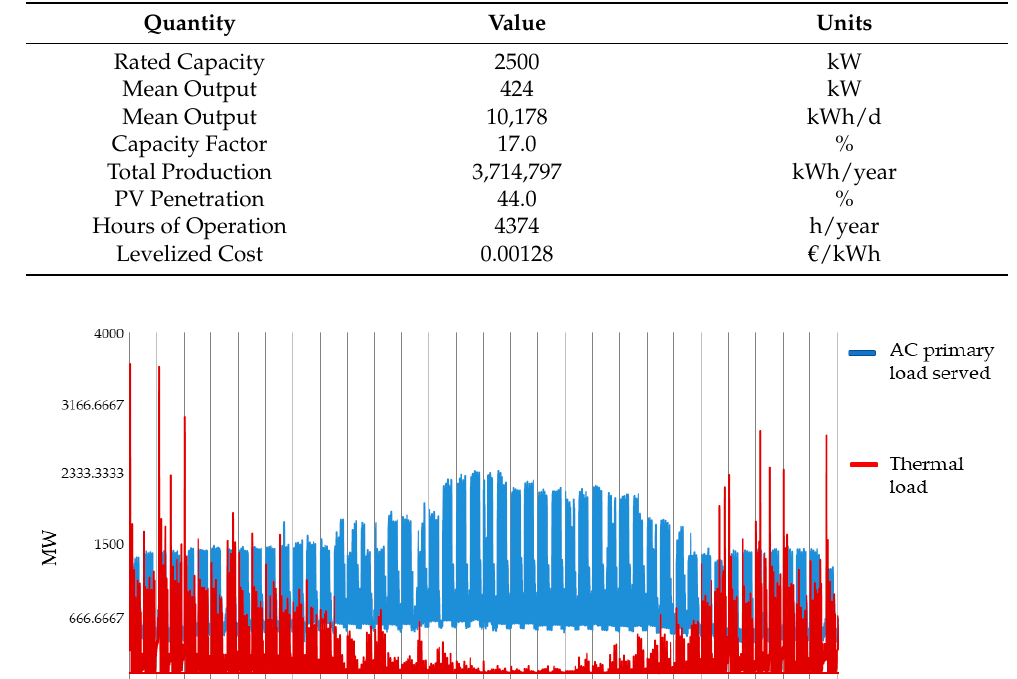
Table 2. Energy production from renewables and grid import.